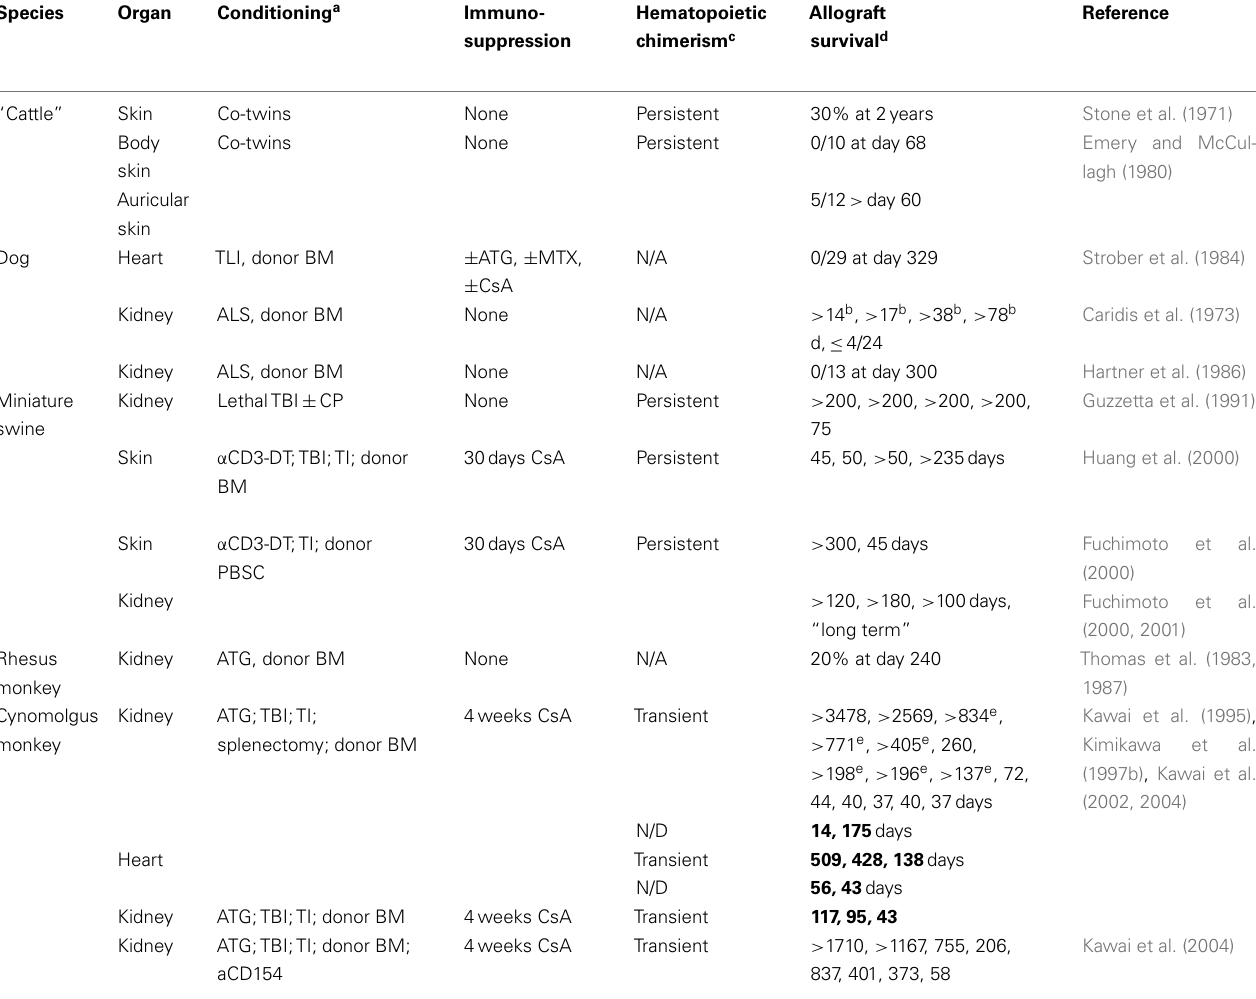
Table 2 | Combined bone-marrow and organ transplantation in large animals and non-human primates.